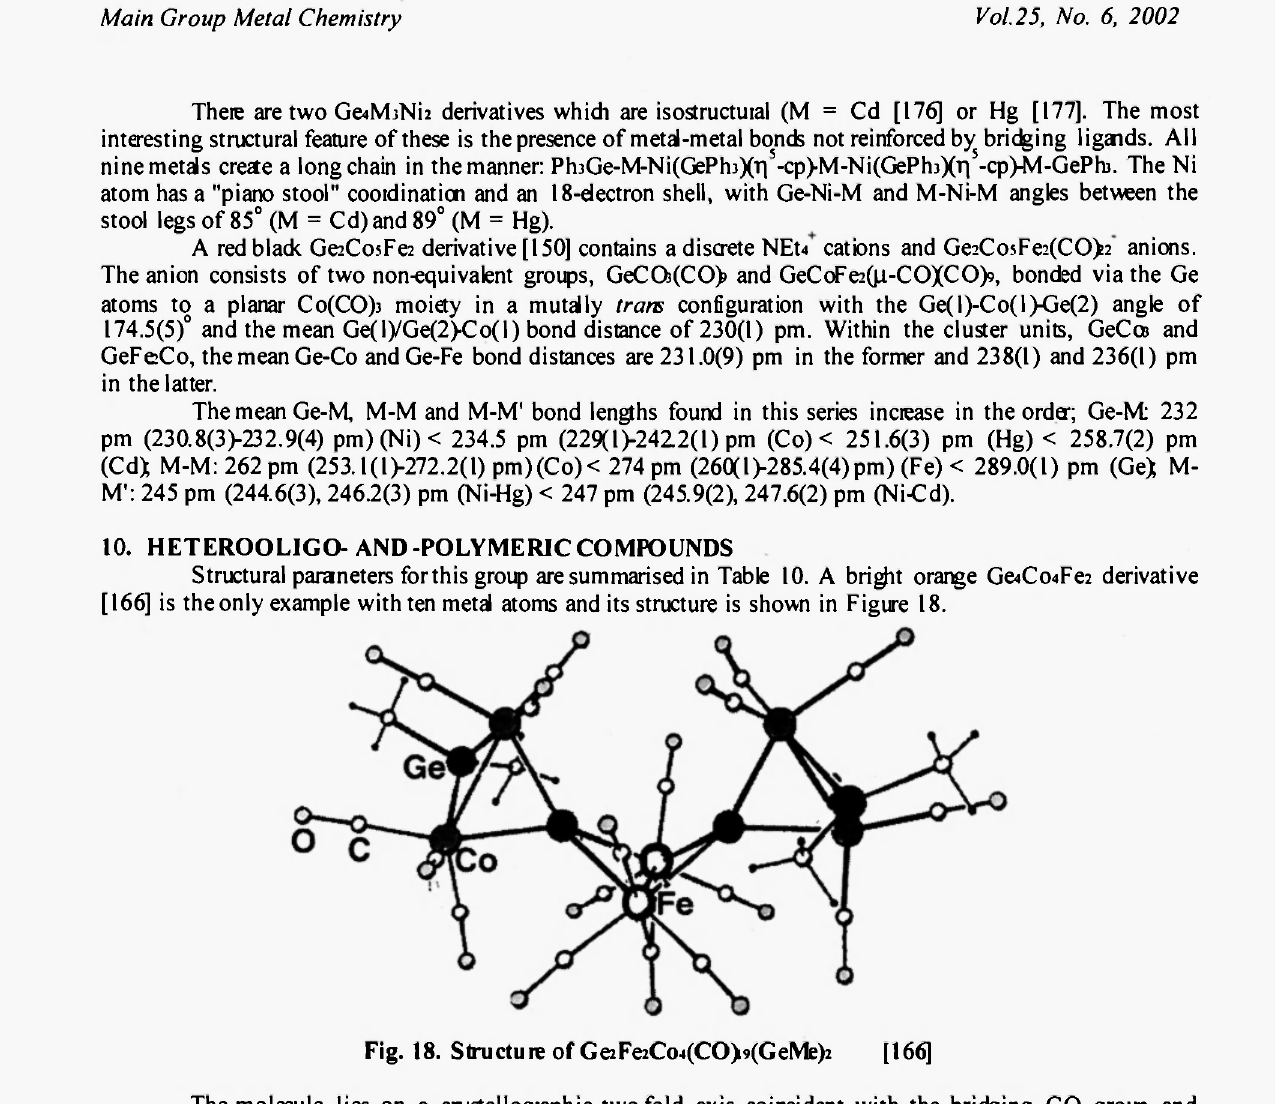
Fig. 18. Structure of